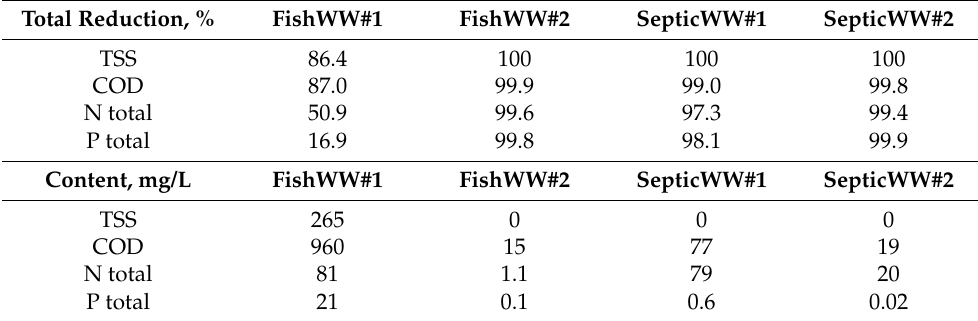
Table 4. The achieved total reductions (%) and the contents (mg/L) of TSS, COD, N total, and P total in the purified water fractions for all four evaluated